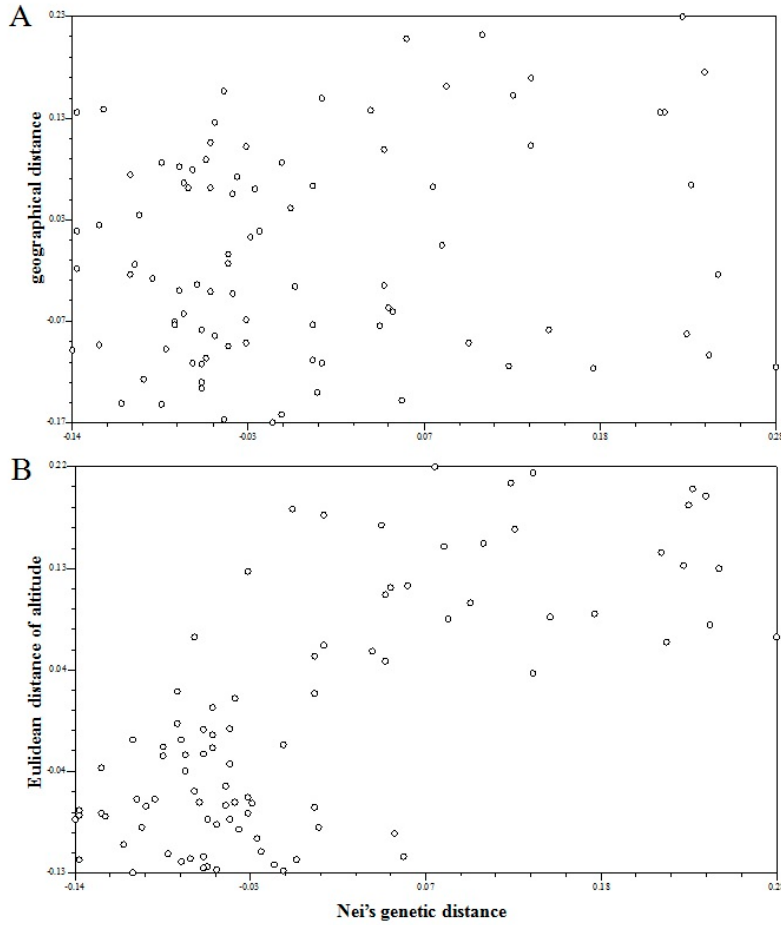
Figure 5. Mantel test. ( A ) Mantel between Nei’s genetic distance and geographical distance of 14 Figure 5 . Mantel test. (A) Mantel between Nei’s genetic distance and geographical distance of 14 A. 126 A. cremastogyne populations. ( B ) Mantel between Nei’s genetic distance and Euclidean distance of cremastogyne populations. (B) Mantel between Nei’s genetic distance and Euclidean distance of 127 elevation for 14 A. cremastogyne elevation for 14 A. cremastogyne populations. 128